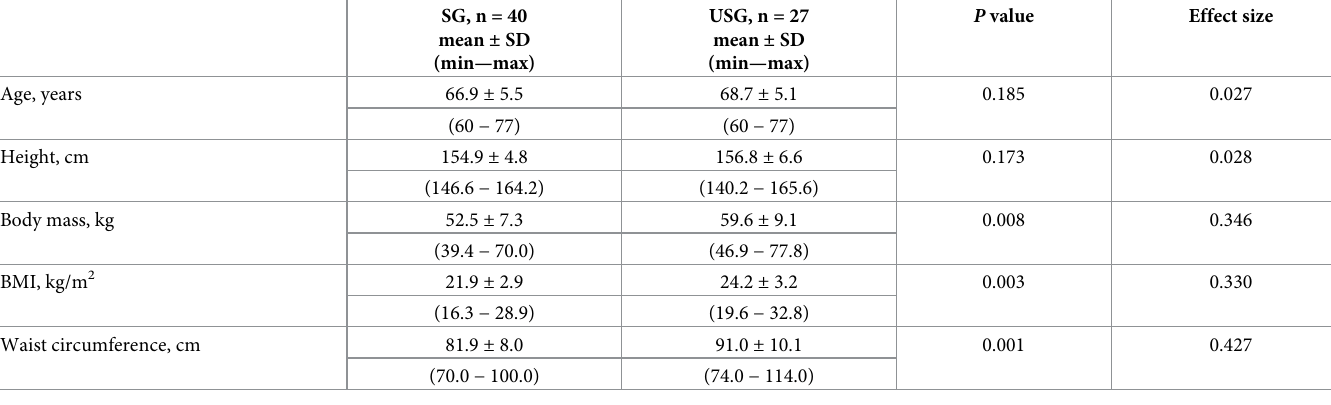
Table 1. Physical characteristics of